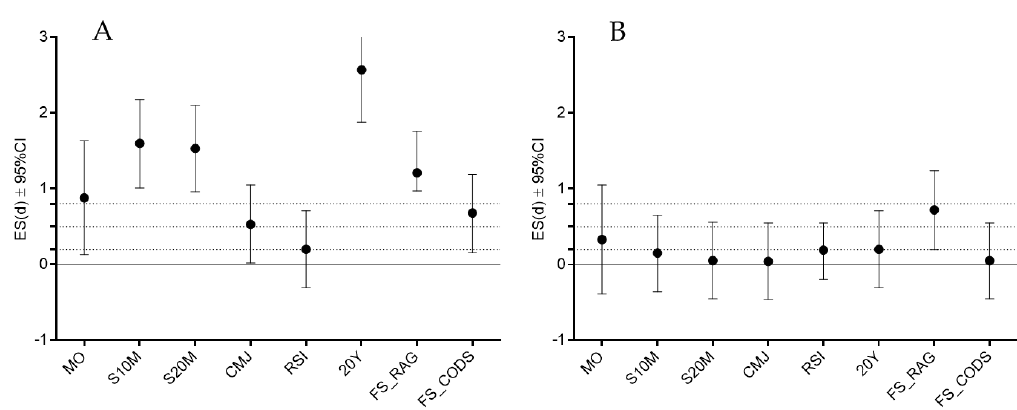
Figure 3. E ff ect size (ES) di ff erences between performance groups (Starters vs Nonstarters) in U13 (A) Figure 3. Effect size (ES) differences between performance groups (Starters vs Nonstarters) in U13 (A) and U15 (B) category. LEGEND: MO—maturity o ff set, S10—sprint 10 meters, S20M—sprint 20 meters, and U15 (B) category. LEGEND: MO — maturity offset, S10 — sprint 10 meters, S20M — sprint 20 CMJ—countermovement jump, RSI—reactive strength index, 20Y—change of direction speed 20 yards meters, CMJ — countermovement jump, RSI — reactive strength index, 20Y — change of direction test, FS_RAG—football specific reactive agility test, FS_CODS—football specific change of direction speed test, < 0.2 trivial ES, 0.21–0.49 small ES, 0.50–0.79 medium ES, > 0.79 strong ES.